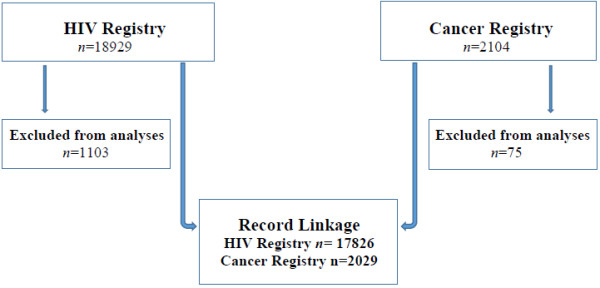
Participants flow chart.